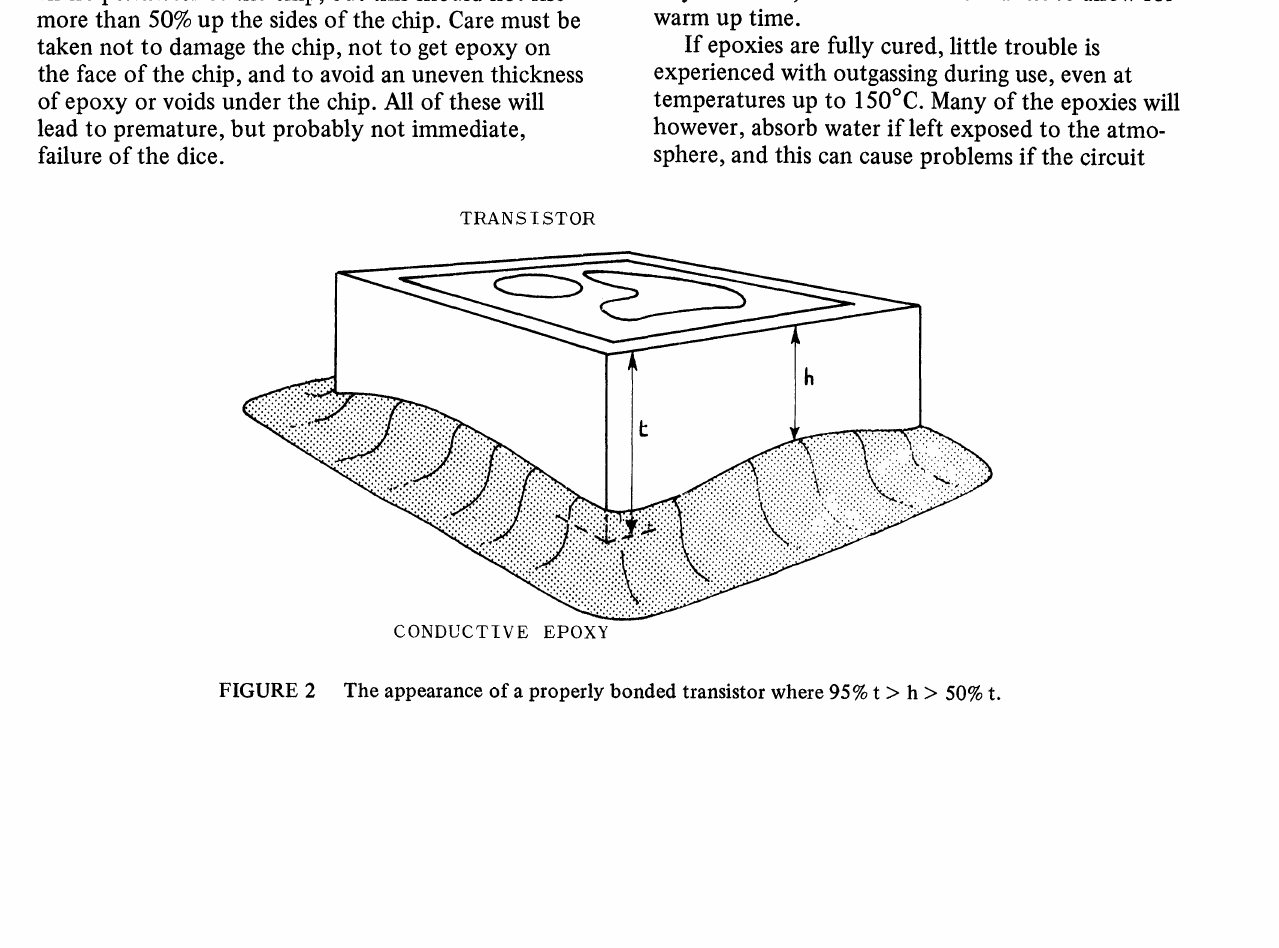
FIGURE 2 The appearance of a properly bonded transistor where 95% > h > 50%